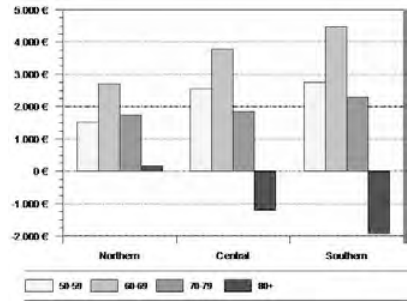
Figure 2: Balance of financial transfers